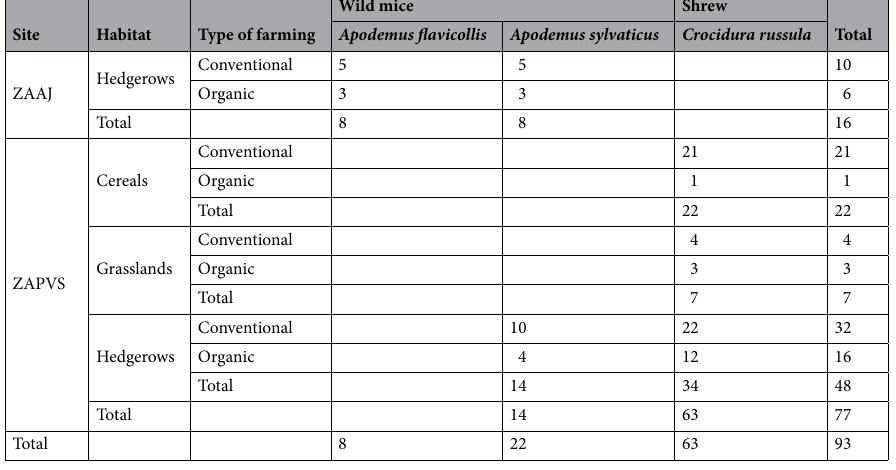
Table 3. Overview of small mammal sample